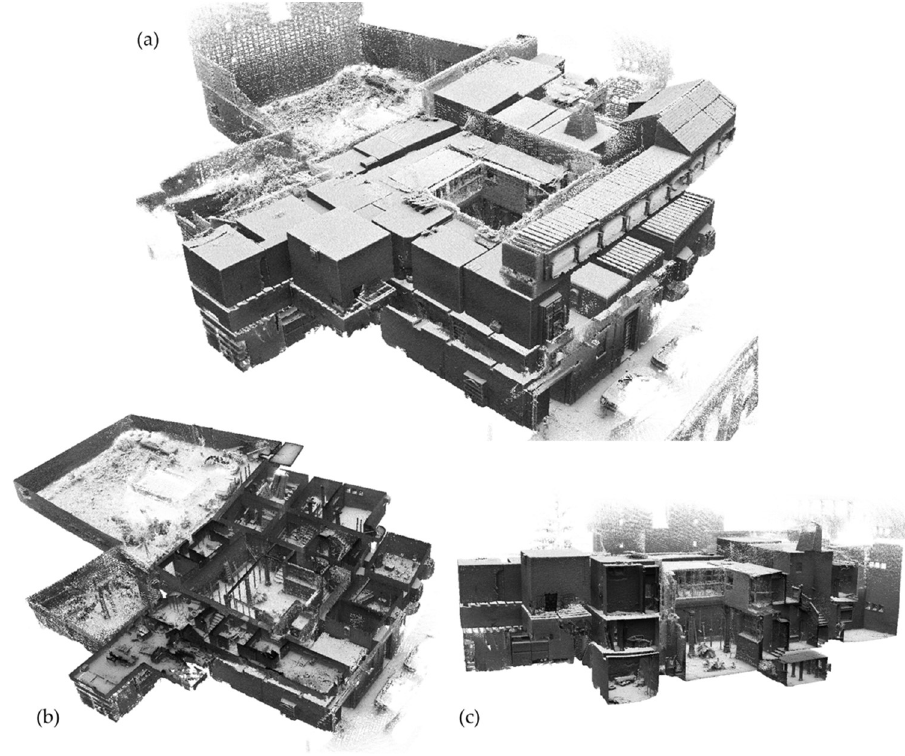
Figure 15. Final point cloud with more than a 100 million points: ( a ) perspective view; ( b ) horizontal section; ( c ) vertical section.